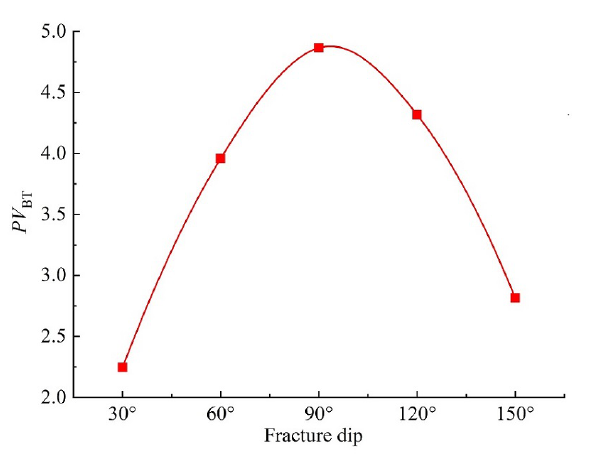
Figure 2. The effect of fracture dip on dimensionless breakthrough volumes corresponds to the dissolution structures in Figure 1 column (A).